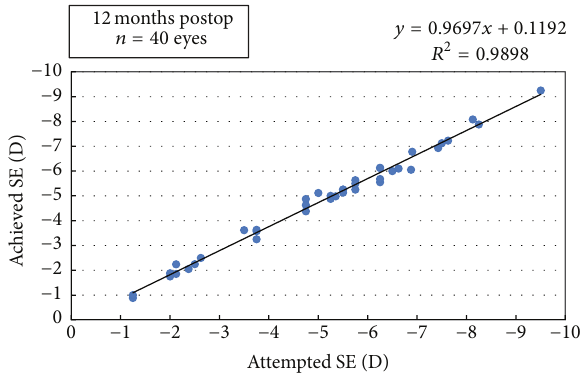
Figure 3: Intended versus achieved correction (manifest) at 12 months (SE: spherical